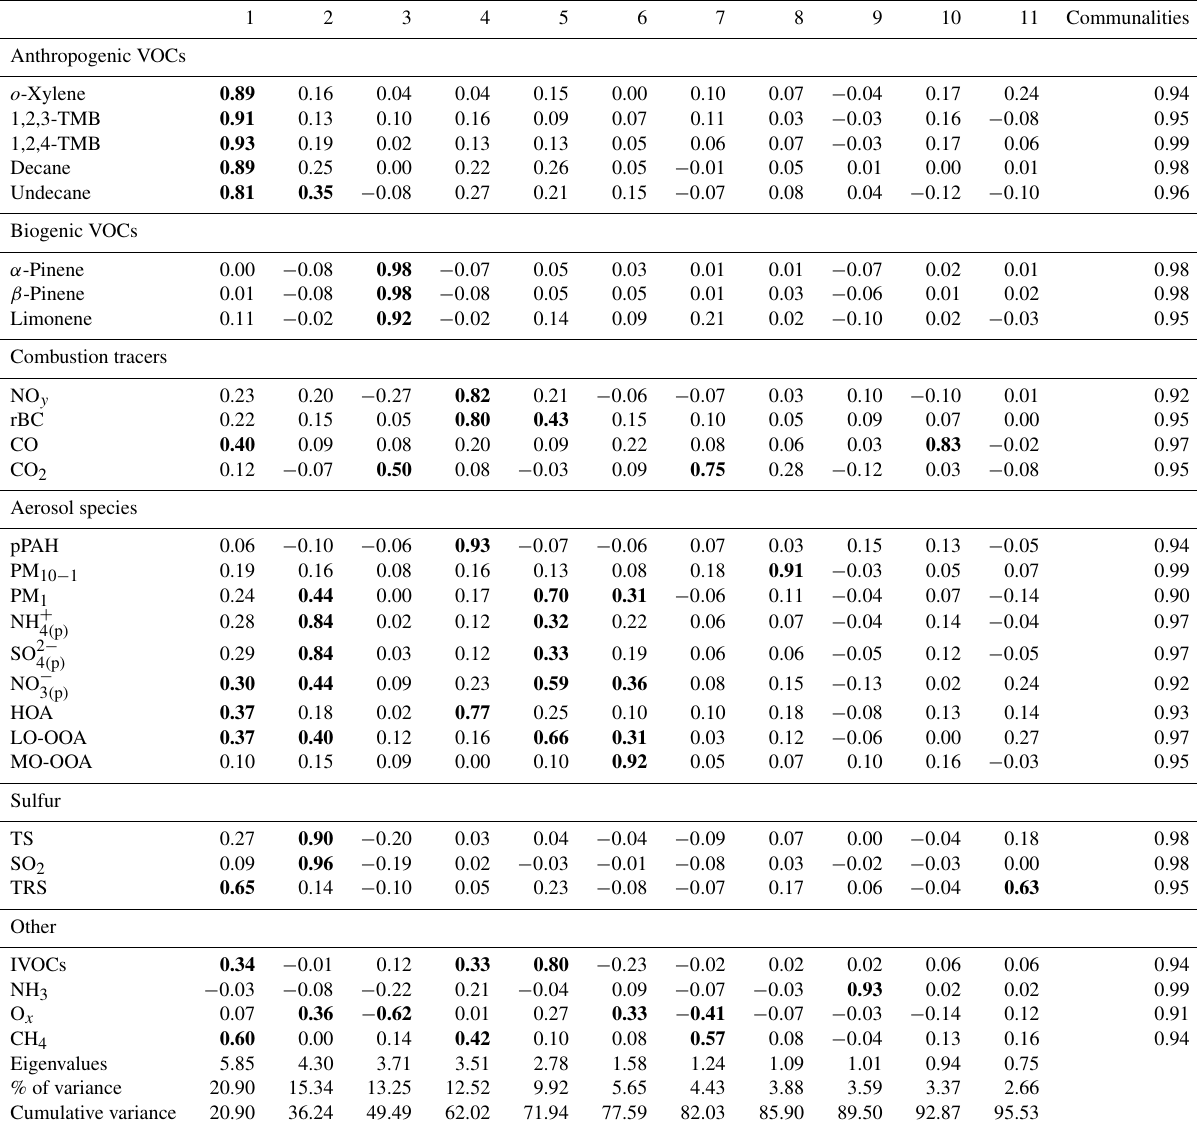
Table 7. Loadings for the 11-component solution with the inclusion of variables associated with secondary processes. 1 2 3